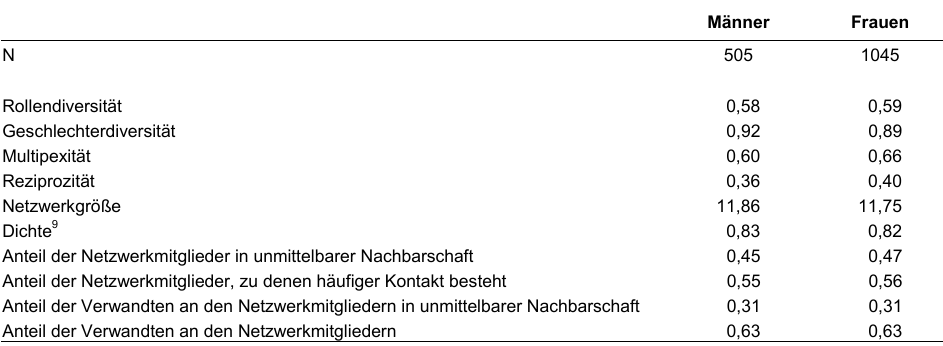
Tabelle 5 : Mittelwerte der Netzstrukturdaten nach